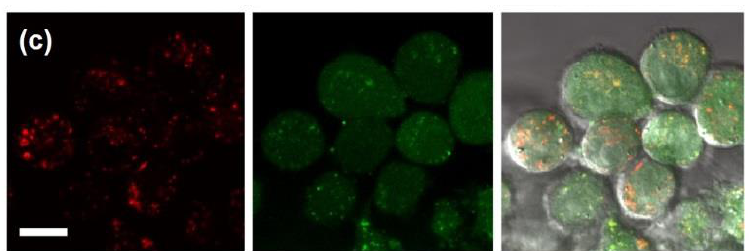
Figure 5. CLSM images of DC2.4 cells treated with FITC-OVA in the absence ( a ) or the presence of DLPC liposomes ( b ) or DLPC/deoxycholic acid micelles ( c ) for 5 h. Cells were also stained with LysoTracker Red. Scale bar represents 10 μm.